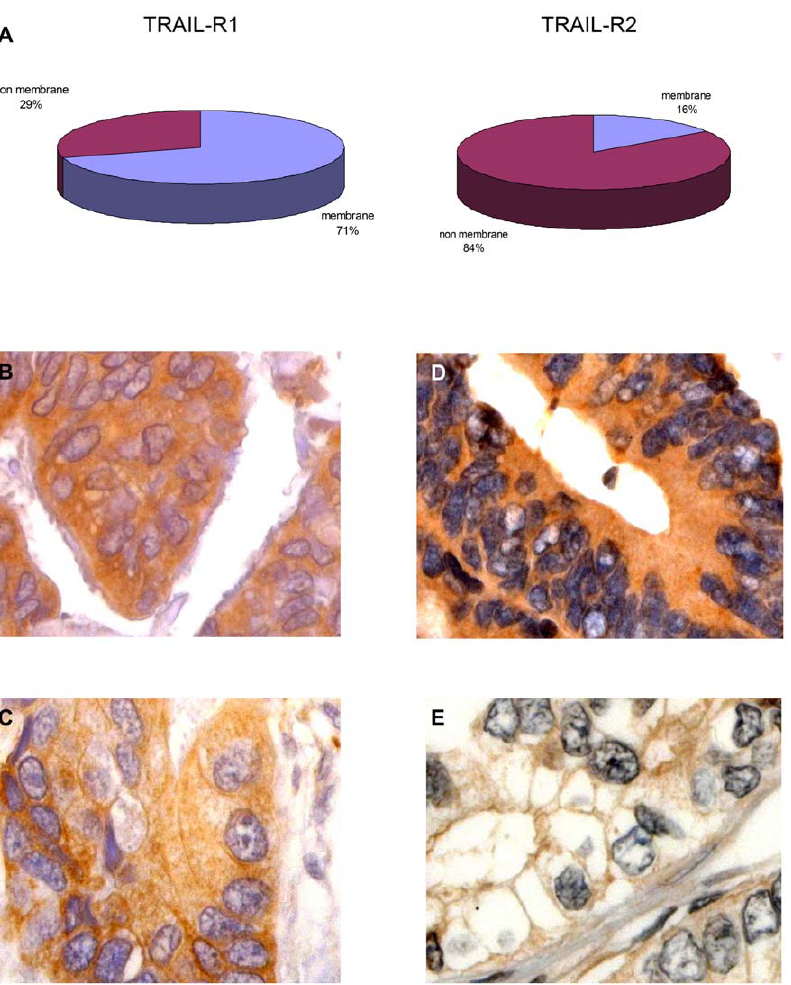
Figure 2. TRAIL-R1 and TRAIL-R2 staining in human colorectal cancer. (A) percentage of tumor samples showing membrane staining for TRAIL-R1 and TRAIL-R2. Representative typical microscopic appearance of TRAIL-R1 staining with predominant cytoplasmatic (B) or membrane staining (C). Typical pattern of TRAIL-R2 staining with predominant cytoplasmatic staining (D) or membrane staining (E). Magnification, 6 800. The present sections are representative of a grade 2 colonic cancer in stage II (T3N0M0) at the magnification of 630 6